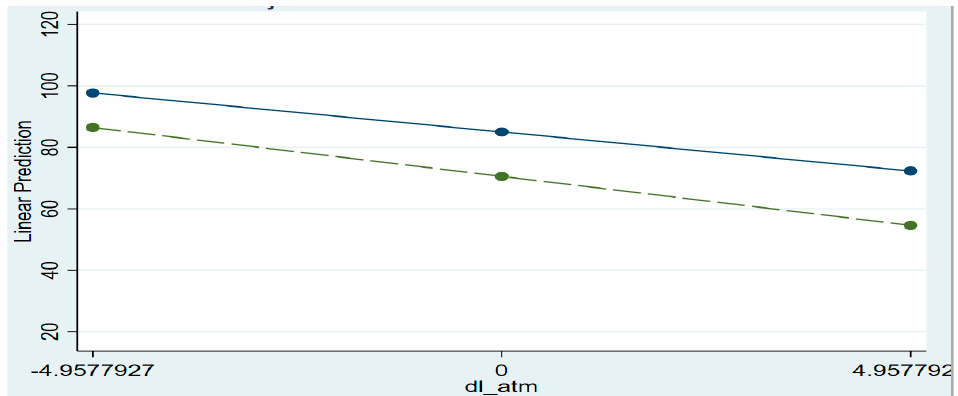
Figure 1. Interaction graph of l_ps_atm. Source: graph created using STATA 16. Note: The solid line of the graph represents the moderating variables’ hig − level impact, whereas the long dash line represents the low impact level.